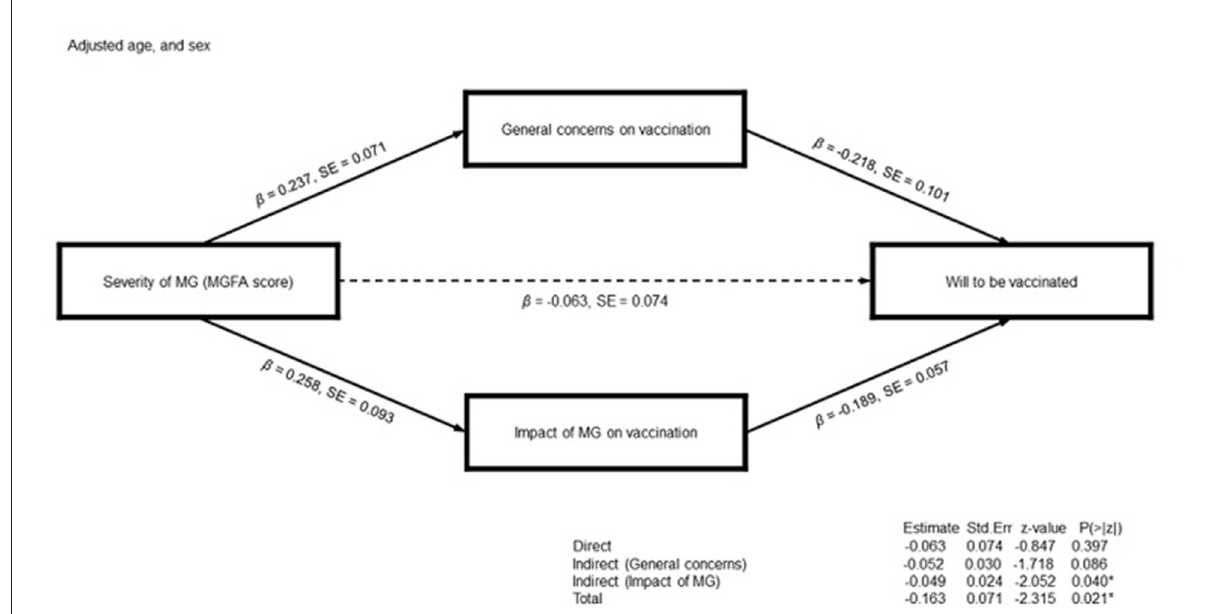
FIGURE1 Schematic diagram of the path analyses for the willingness to get vaccinated against Coronavirus disease 2019. General concerns over vaccination and the impact of myasthenia gravis (MG) diagnosis on vaccination decision are the mediator variables for the likelihood to get vaccinated. The severity of MG assessed by Myasthenia Gravis Foundation of America (MGFA) classification is a predictor. Age and sex are the covariates. The numbers on paths indicate standardized coefficients. The indirect path of MG severity on vaccination willingness using the impact of MG diagnosis on vaccination as mediator variables is statistically significant: high MG severity demonstrates a negative influence on vaccination willingness by increasing the impact of MG diagnosis on vaccination